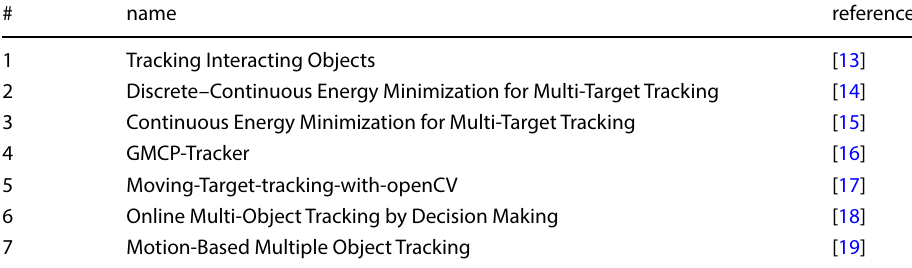
Table 1 List of some tested algorithms for objects segmentation and